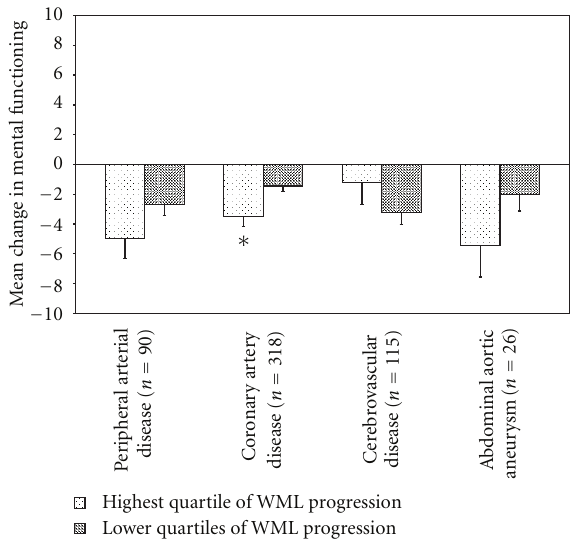
Figure 3: Mean changes in mental functioning for patients with greatest progression of white matter lesion (WML) volume versus patients in the lower three quartiles of progression, for di ff erent locations of symptomatic atherosclerotic disease, adjusted for age, sex, baseline functioning, and follow-up time. Significant di ff erences are indicated with an